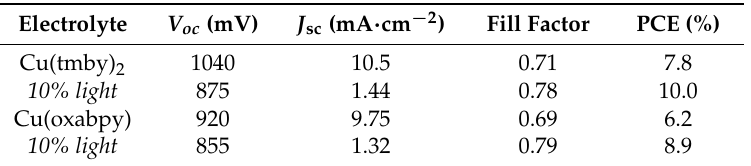
Table 2. J – V characteristics for Y123-sensitized solar cells with Cu(tmby) 2 and Cu(oxabpy) electrolyte under full AM 1.5G and under 10% light intensity. For detailed characterization, the reader is referred to Figures S6–S9 in the Supporting